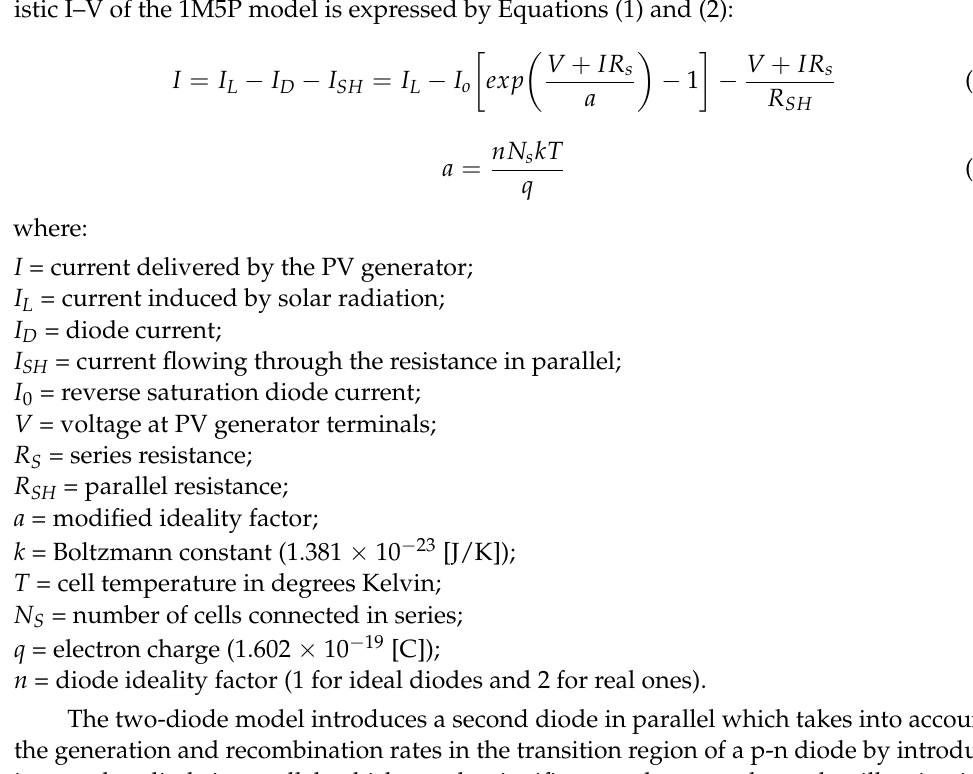
Figure 5. Equivalent model of a PV generator. Source [14], own elaboration. The equivalent circuit shown can be used as a single cell, a multi-cell module, or an array of multiple modules. Considering temperature and constant radiation, the